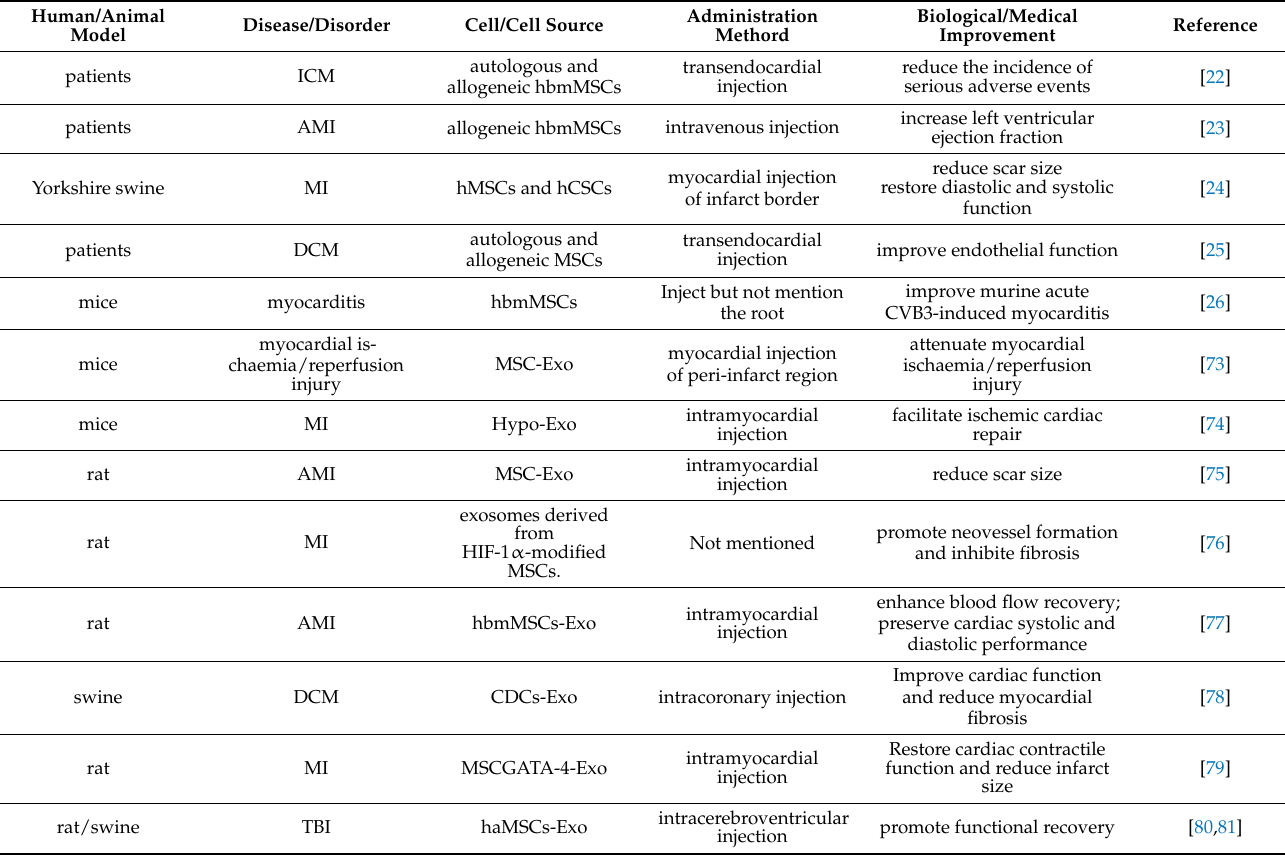
Table 1. Example of MSCs-Exo against cardiovascular